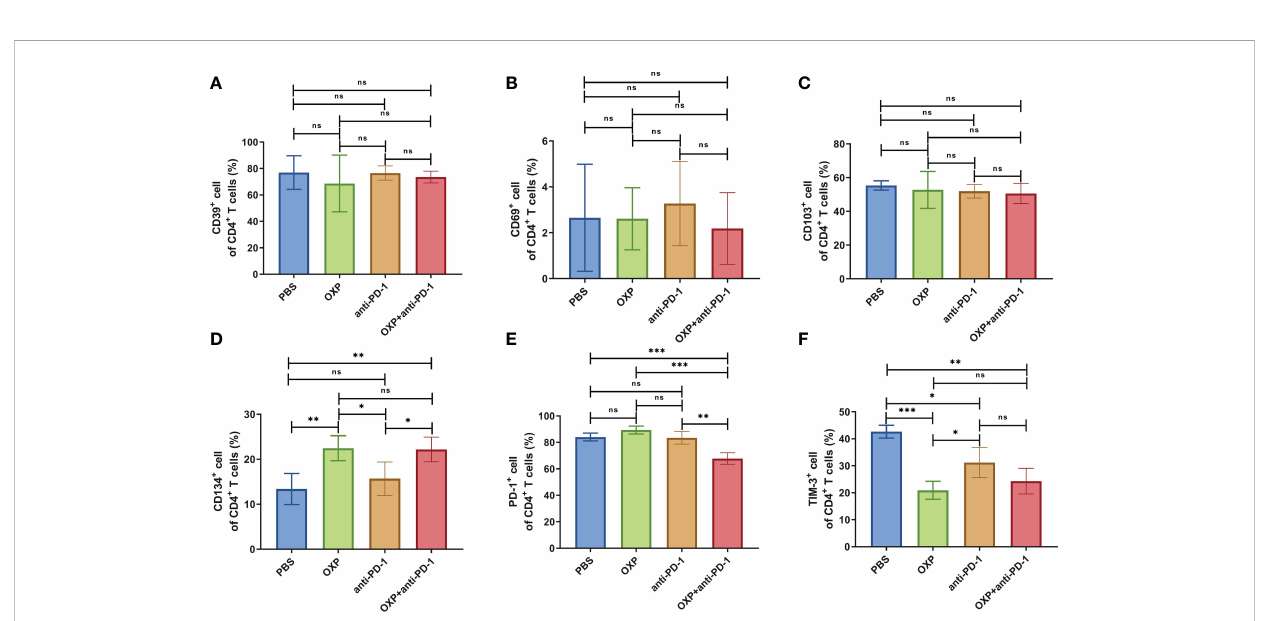
FIGURE 4 The phenotype of CD4 + T cells in TIME. (A) The percentage of CD39 + cells of CD4 + T cells. (B) The percentage of CD69 + cells of CD4 + T cells. (C) The percentage of CD103 + cells of CD4 + T cells. (D) The percentage of CD134 + cells of CD4 + T cells. (E) The percentage of PD-1 + cells of CD4 + T cells. (F) The percentage of TIM-3 + cells of CD4 + T cells. ns P > 0.05, *P < 0.05; **P < 0.01; ***P <